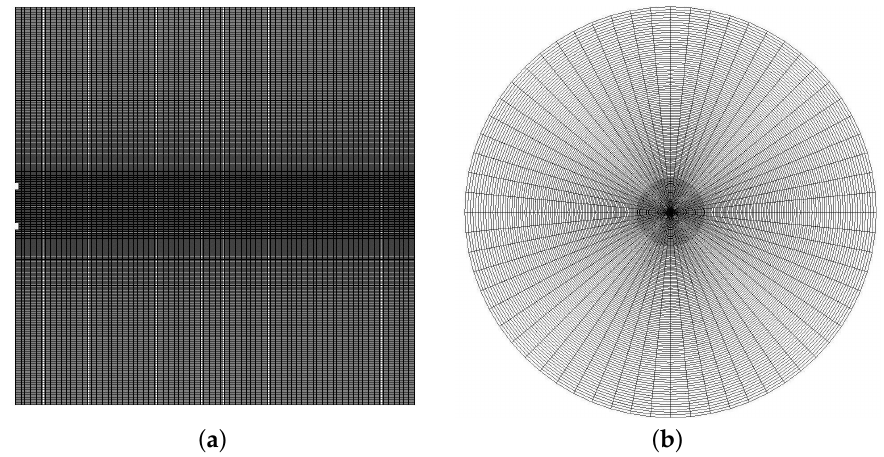
Figure 2. Schematic diagram of meshing. ( a ) plane across central axis ( b ) x = 0